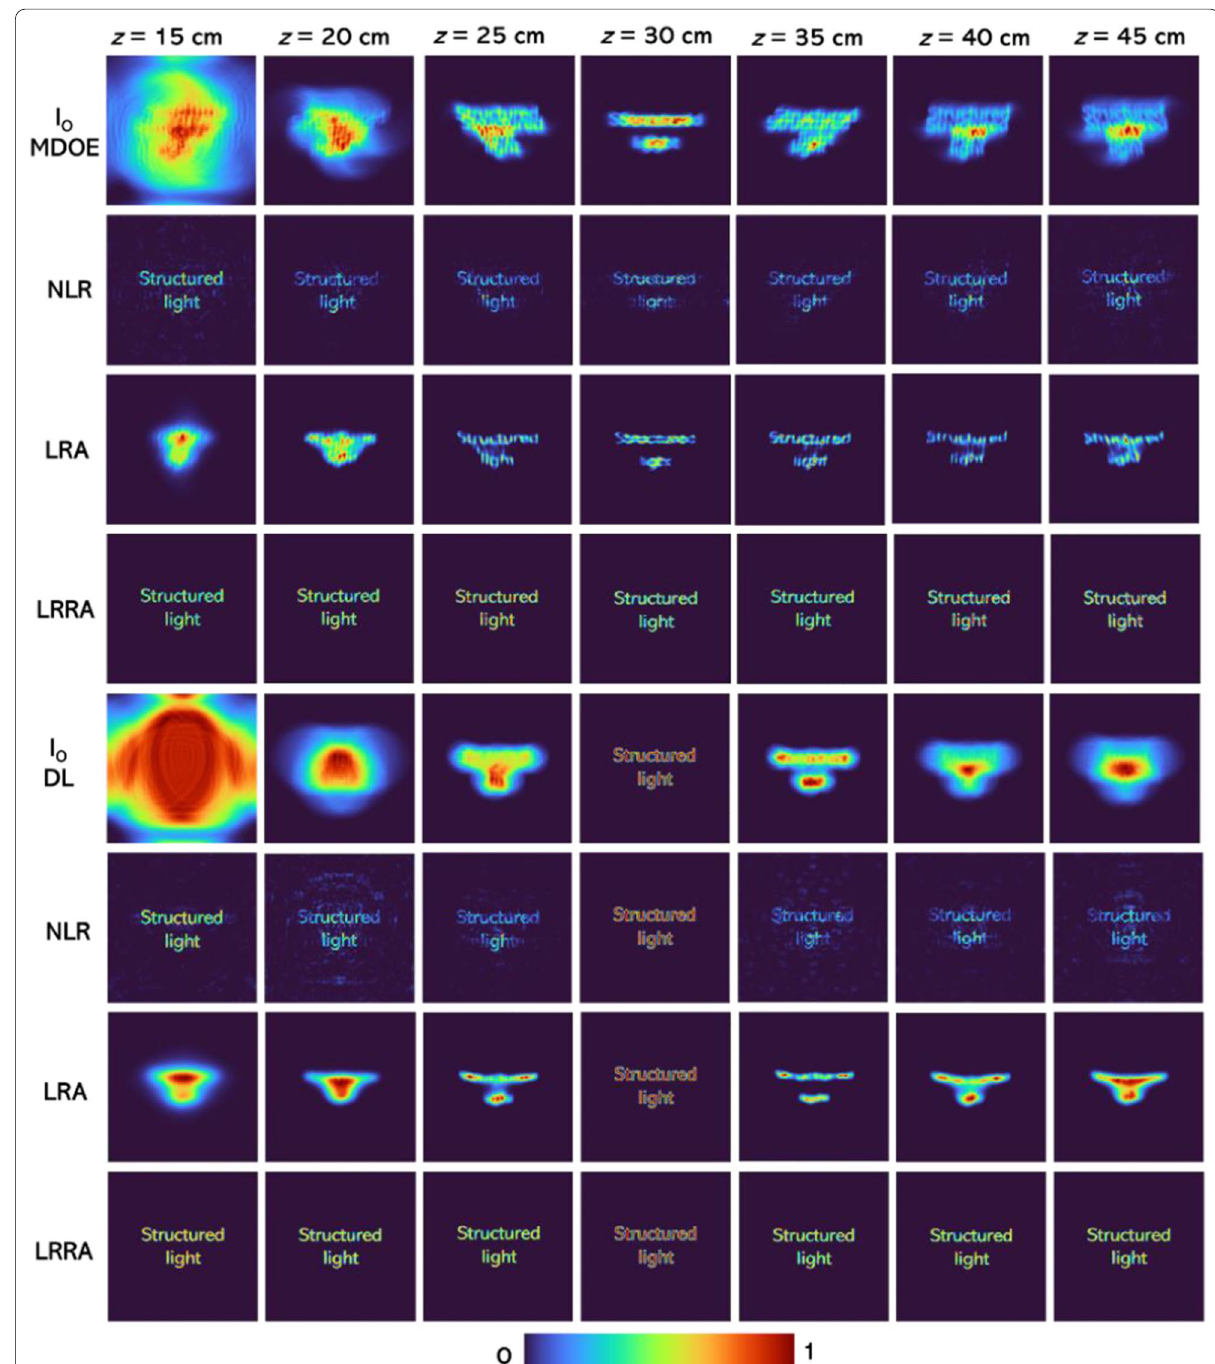
Fig. 5 Simulated intensity distributions for the test object for MDOE and DL and reconstruction results from NLR, LRA and